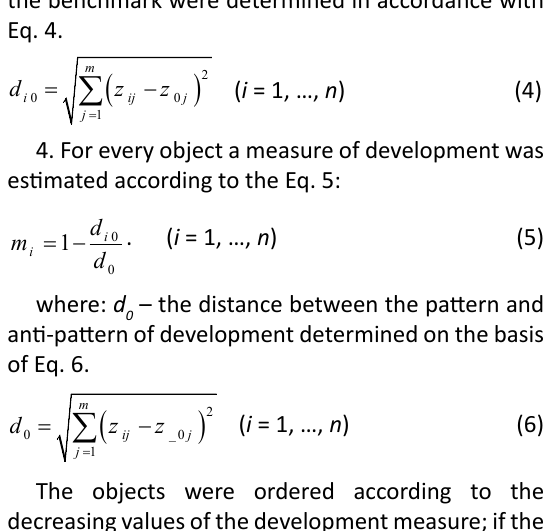
Table 1: Results of linear classification – synthetic measure of development of the entrepreneurship rate